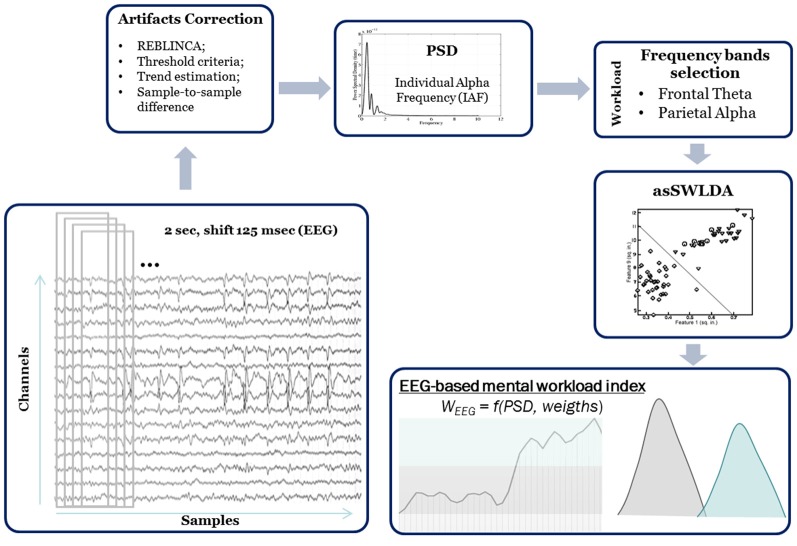
Electroencephalography (EEG) processing chain for the WEEG index computation.